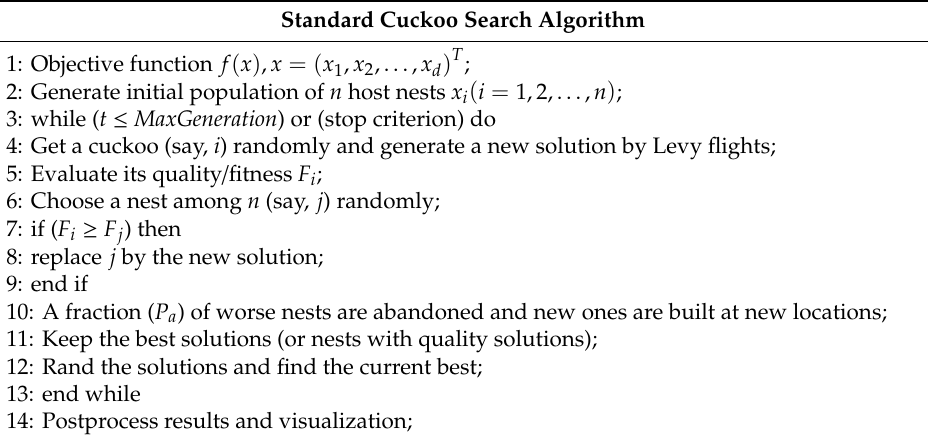
Table 2. Basic calculation process of the standard cuckoo search algorithm.